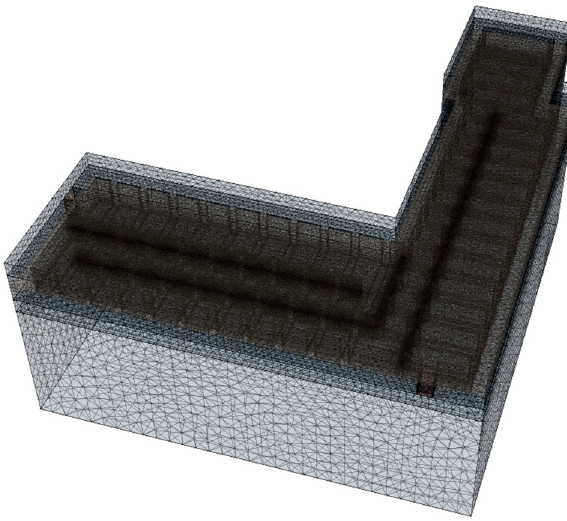
Figure 4. Scene with its mesh.